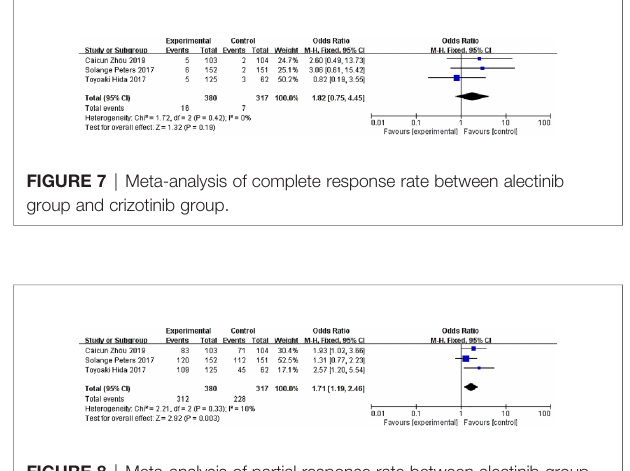
FIGURE 5 | Meta-analysis of alectinib group and crizotinib group progression-free survival.